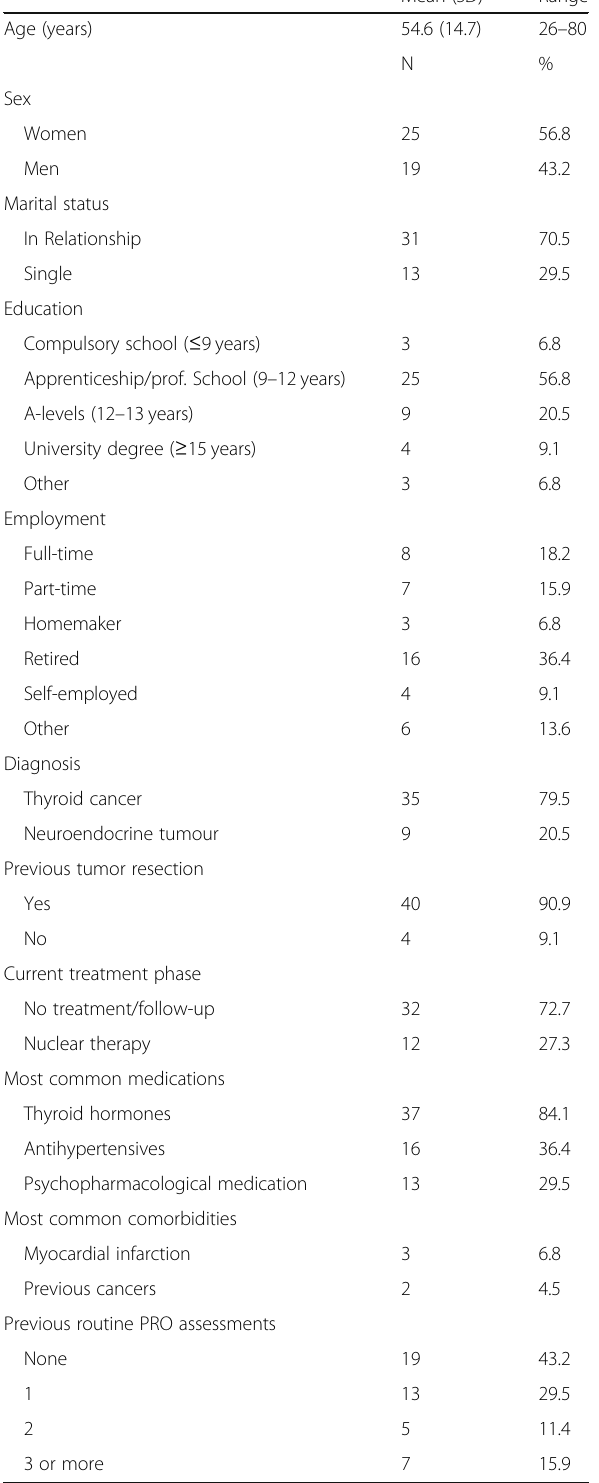
Table 1 Sample characteristics ( N =